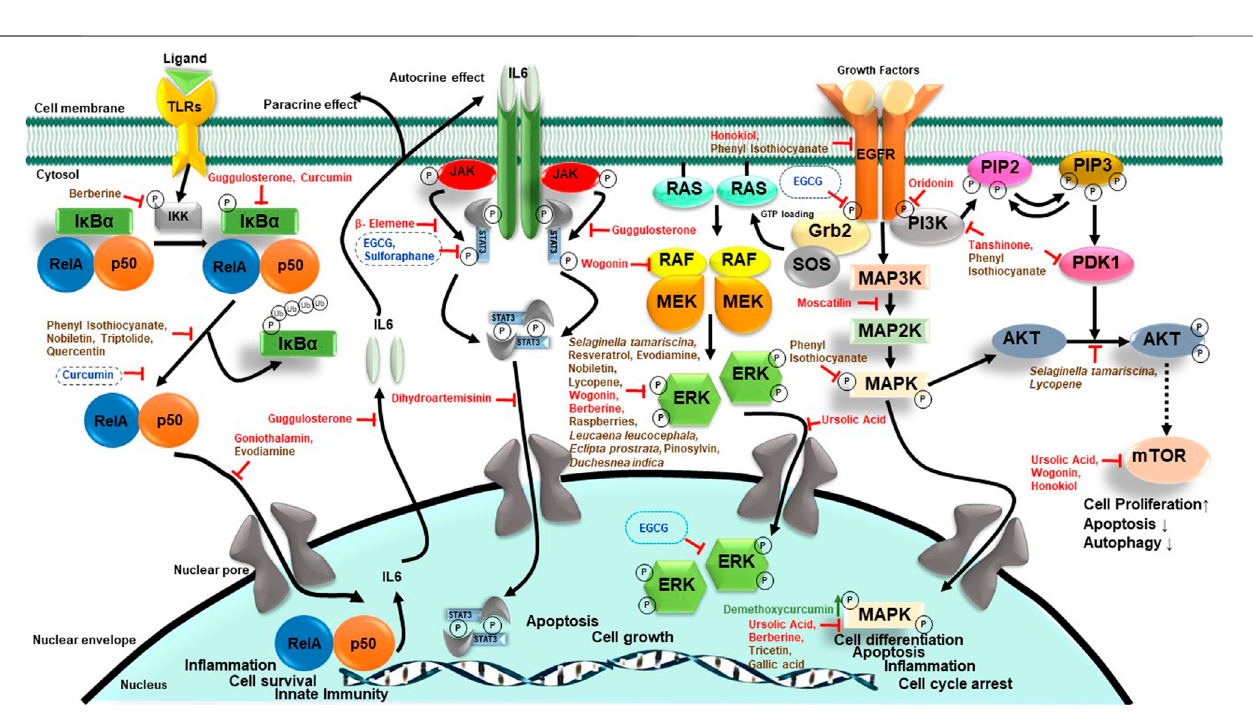
FIGURE 4 | Effect of phytochemicals on different oncogenic signaling pathways of HNC. Summarized here are chemotherapeutic ( red ) and chemopreventive ( brown ) phytochemicals that target different signaling pathways along with speci fi c phytochemicals ( blue ) demonstrating anti-HPV activity in HPV-positive HNC.